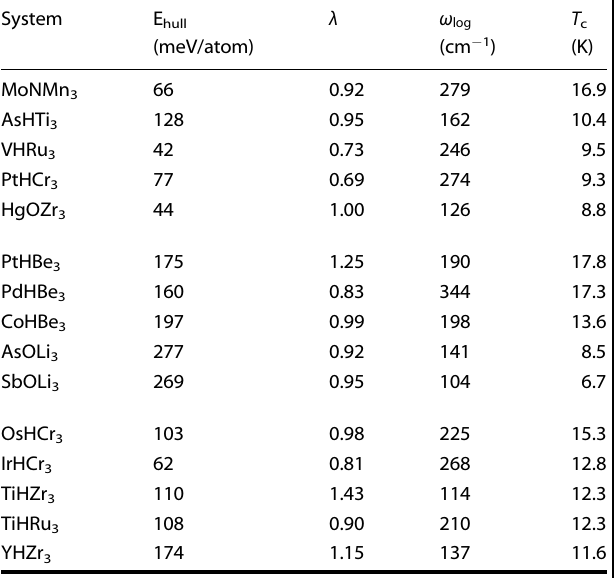
Top panel: systematic high-throughput search; Middle panel: XY{Li,Be} 3 compounds; Bottom panel: Superconductors predicted by our machine- learning models. Note that in total we discovered 16 (73) compounds within 50meV/atom (400meV/atom) from the convex hull and with T c > 5. Values calculated with a 4 ×4 × 4 q